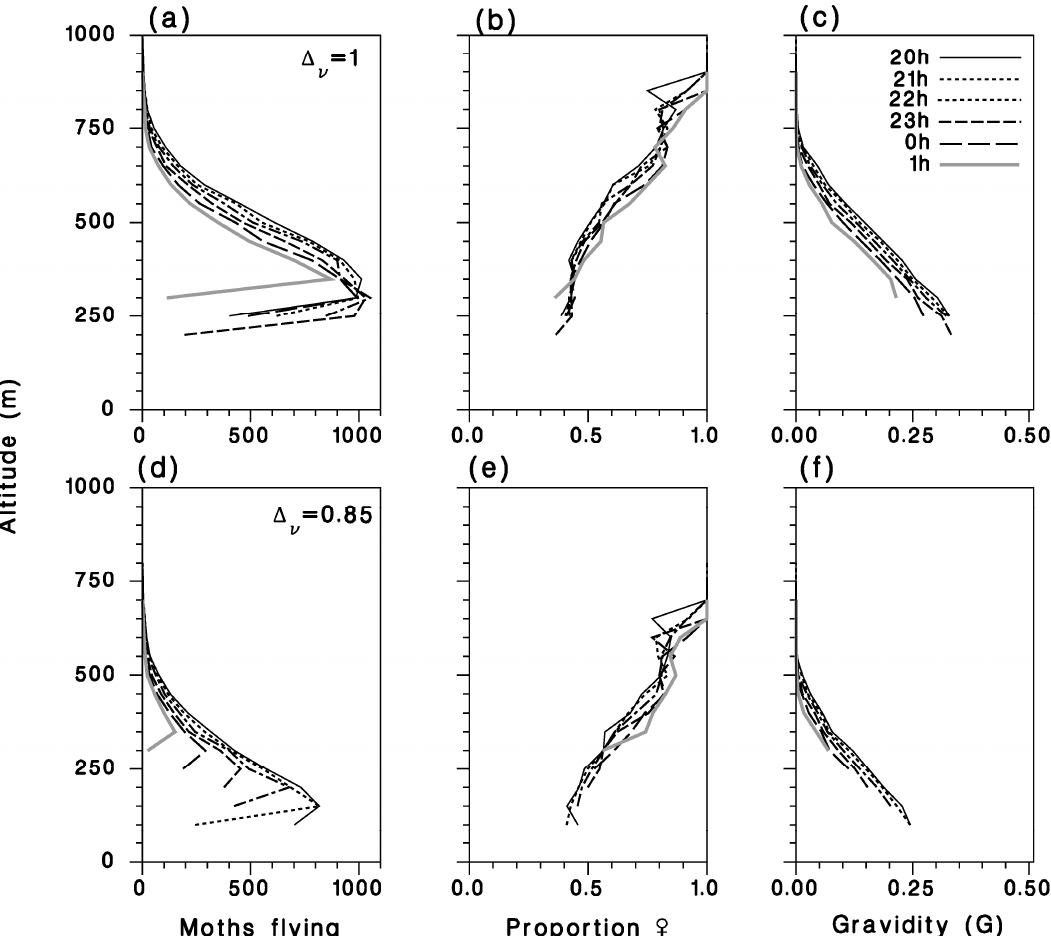
Figure 9. Hourly vertical density profiles of simulated migrating moths between liftoff at 20:00 (sunset) and 01:00 the next morning. Top row: Δ ν = 1.0; bottom row: Δ ν = 0.85. ( a , d ) Number of moths flying. ( b , e ) Proportion female. ( c , f ) Gravidity, the proportion of initial fecundity carried by females.